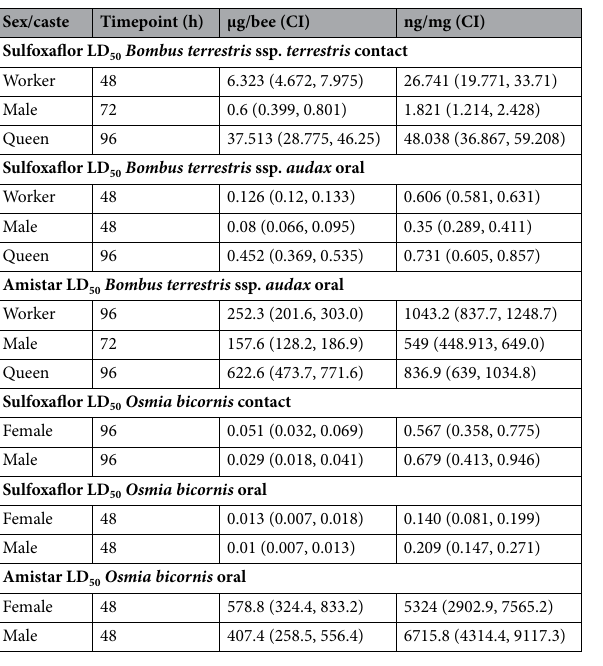
Table 1. The acute toxicity of sulfoxaflor and Amistar to B. terrestris and O. bicornis across castes and sexes. LD 50 values and related 95% confidence intervals were calculated at timepoints corresponding to the steady- state mortality except in the case of O. bicornis oral exposure to sulfoxaflor and Amistar (see methods section). All endpoints are expressed as doses, normalised or not by body